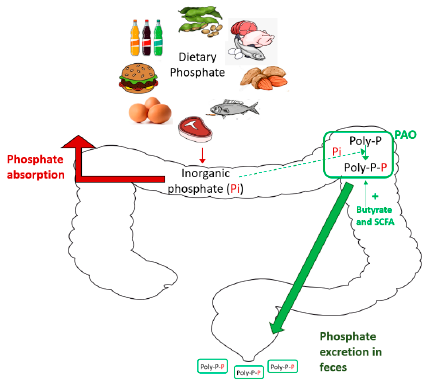
Figure 2. Phosphate-accumulating organisms (PAOs) to prevent positive phosphate balance in CKD.